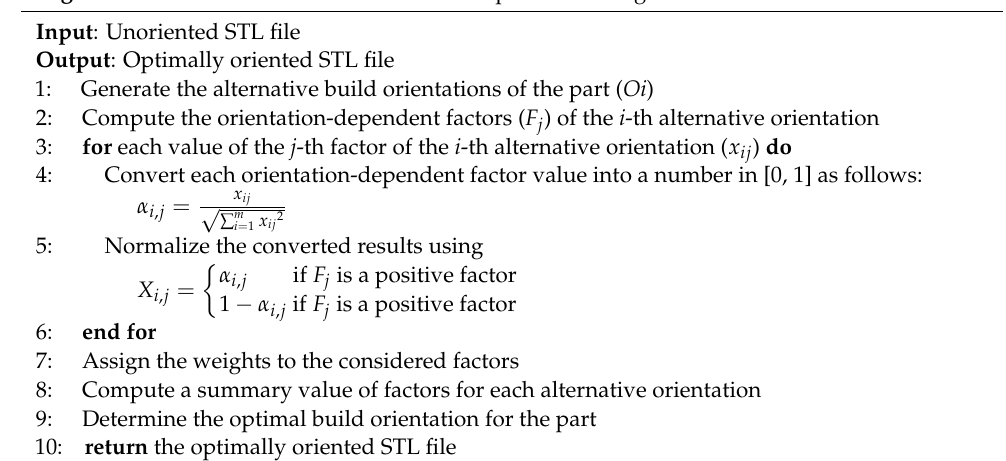
Algorithm 1: Pseudocode for the orientation optimization